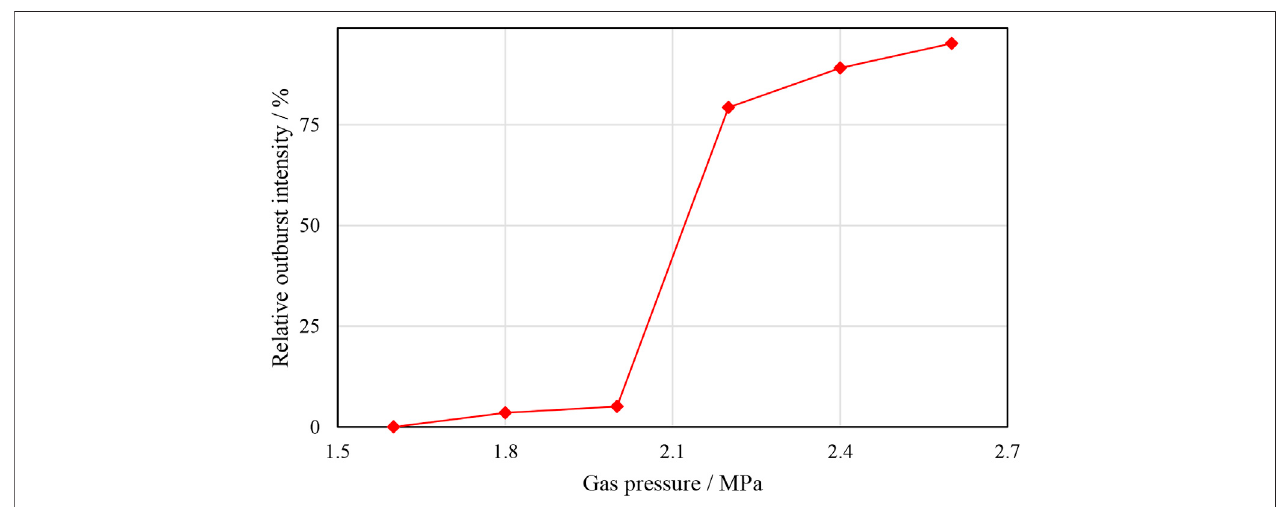
FIGURE 10 | Relative outburst intensity of the experimental coal and gas outburst under different gas pressures from 1.6 to 2.6 MPa.